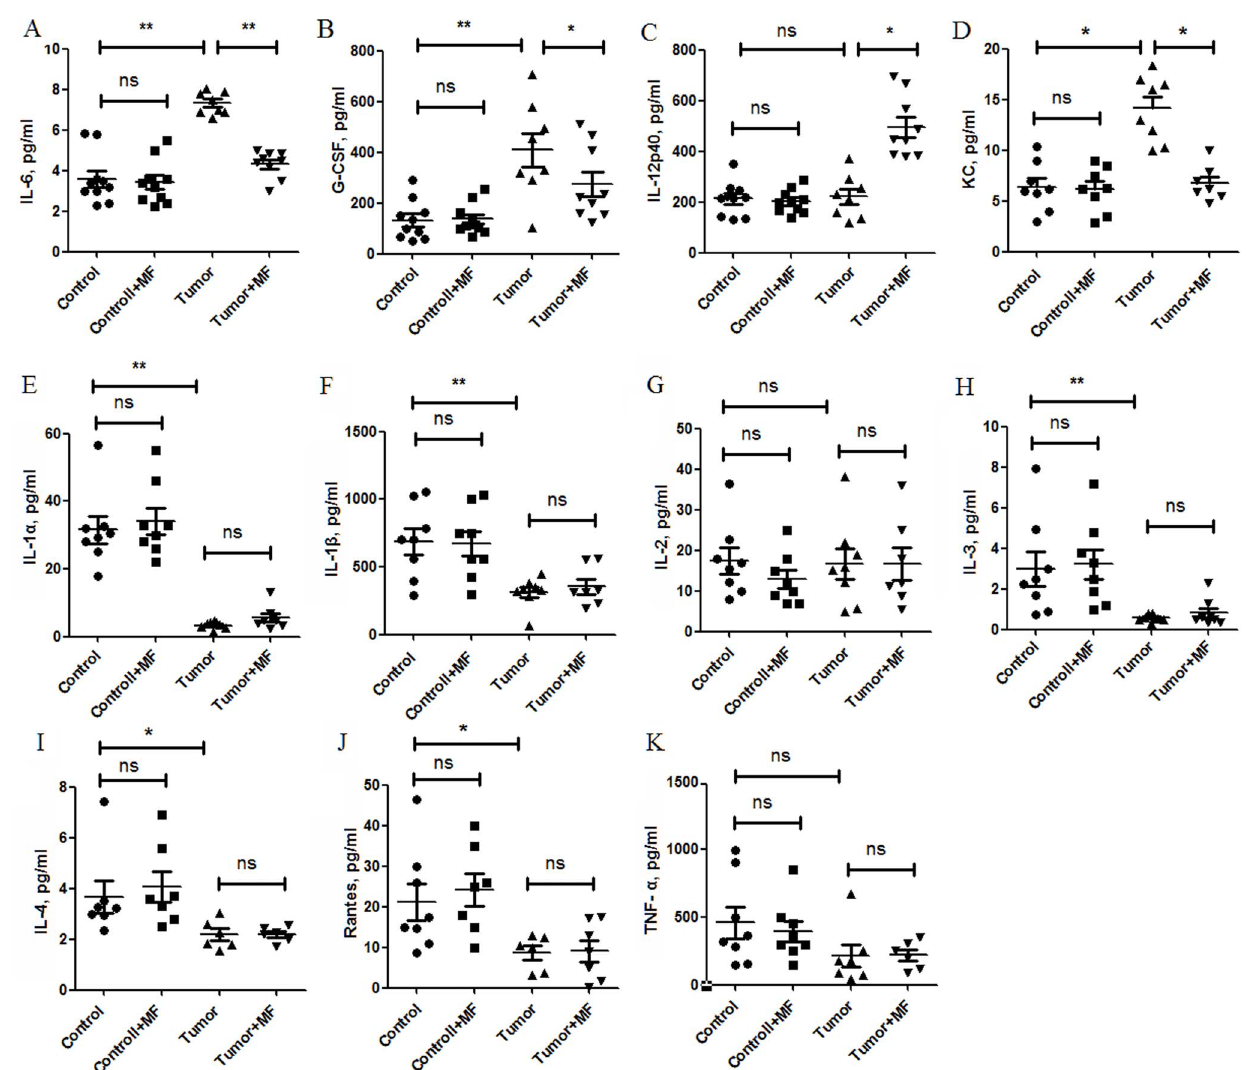
Figure 2. Magnetic fields raise survival rate and inhibit tumor growth in tumor-bearing mice. (A) Statistical analyses of survival after subcutaneous challenge of Balb/c mice with H22 cells and treated with magnetic fields using log-rank test. Mice were treated by magnetic fields (MF) for 30 days, 2 h per day, and cared without magnetic fields for another 40 days. (B) The mean mass and volume of tumor for each group after treatment with magnetic fields 30 days. *** P , 0.001, Mann-Whitney U test. The Hematoxylin and eosin staining (C, 10 6 ) and immunohistochemical staining of Ki67 (D) in tumors.